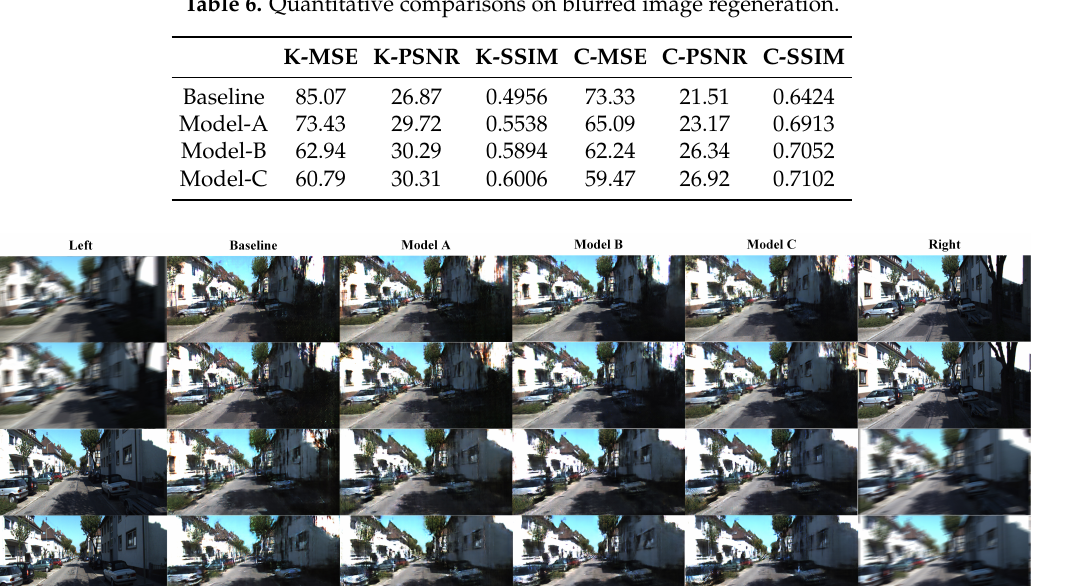
Table 6. Quantitative comparisons on blurred image regeneration.